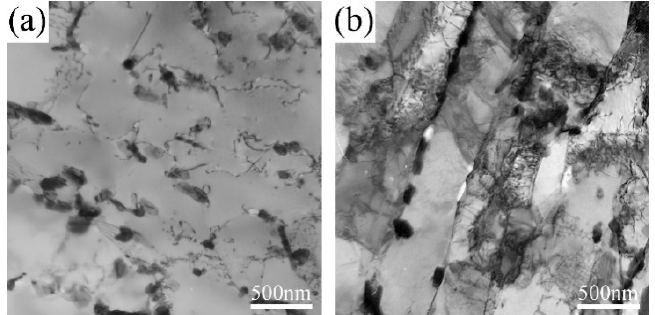
Figure 9. TEM micrographs of 9Cr-3W-3CO creep rupture specimens under stress of 200 MPa: ( a ) gauge, ( b ) grip.